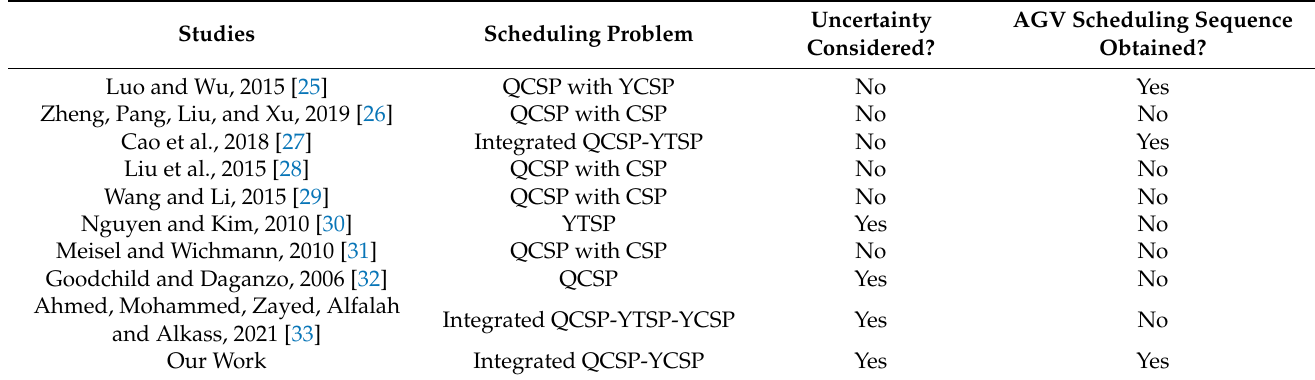
Table 1. The problems solved by using double-cycling